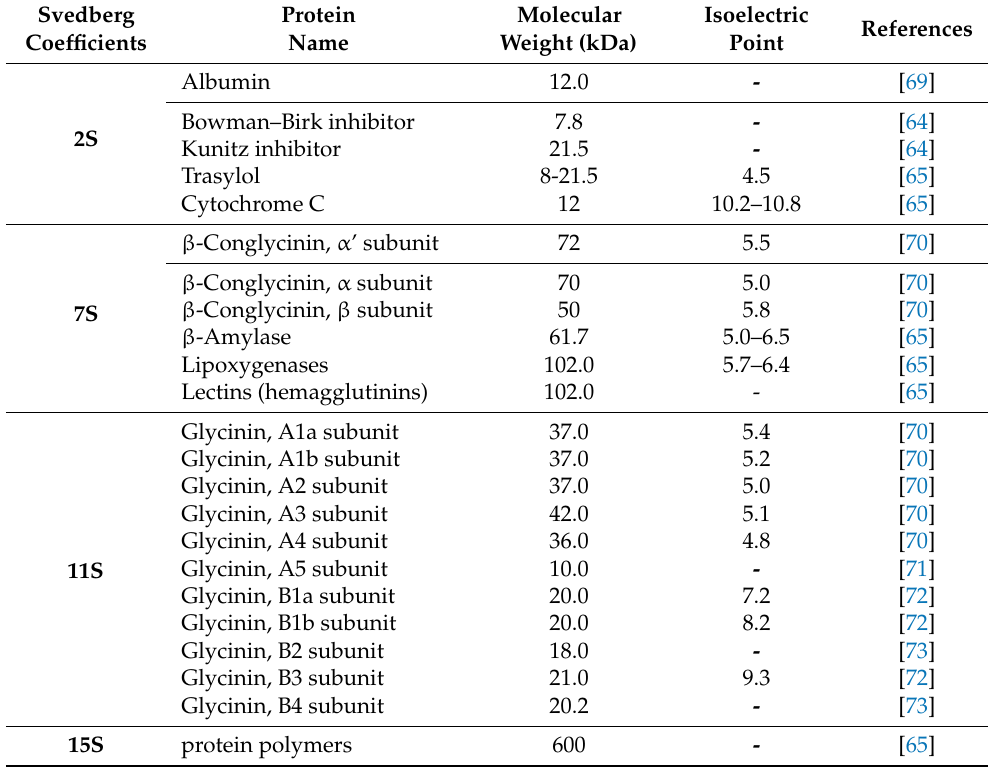
Table 1. The protein composition included 2S, 7S, 11S, and 15S in